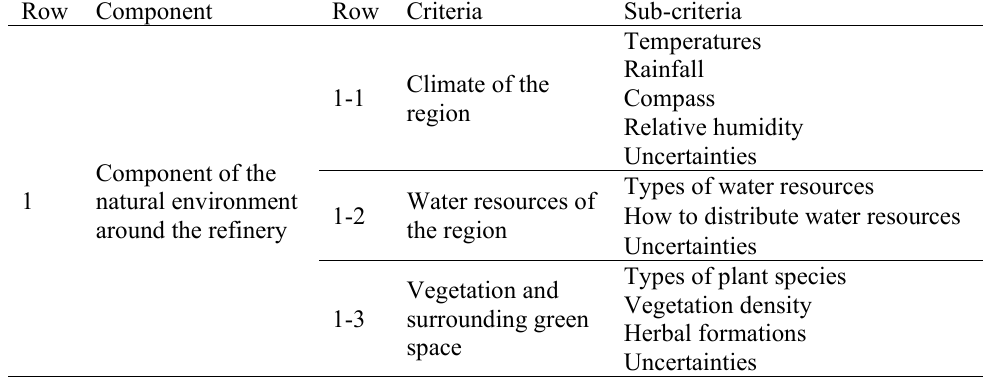
Table 1. Strategic components and criteria for component of natural environment around refinery Row